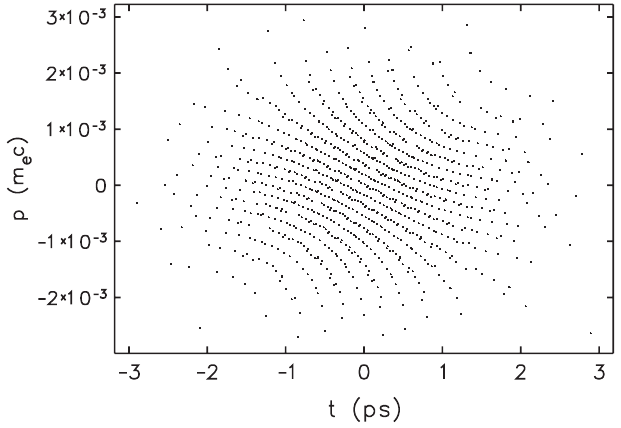
FIG. 2. Illustration of banding in longitudinal phase space when Halton radices of 11 and 13 are used for time and momentum coordinates, respectively. Banding becomes less evident as the number of particles is increased and when the ratio of the radices is far from